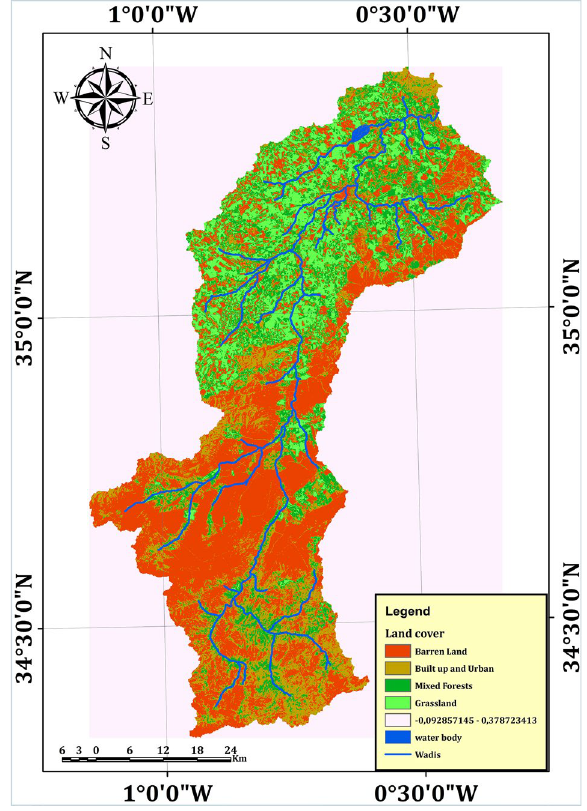
Fig. 2 Map of land cover of oued Mekerra catchment